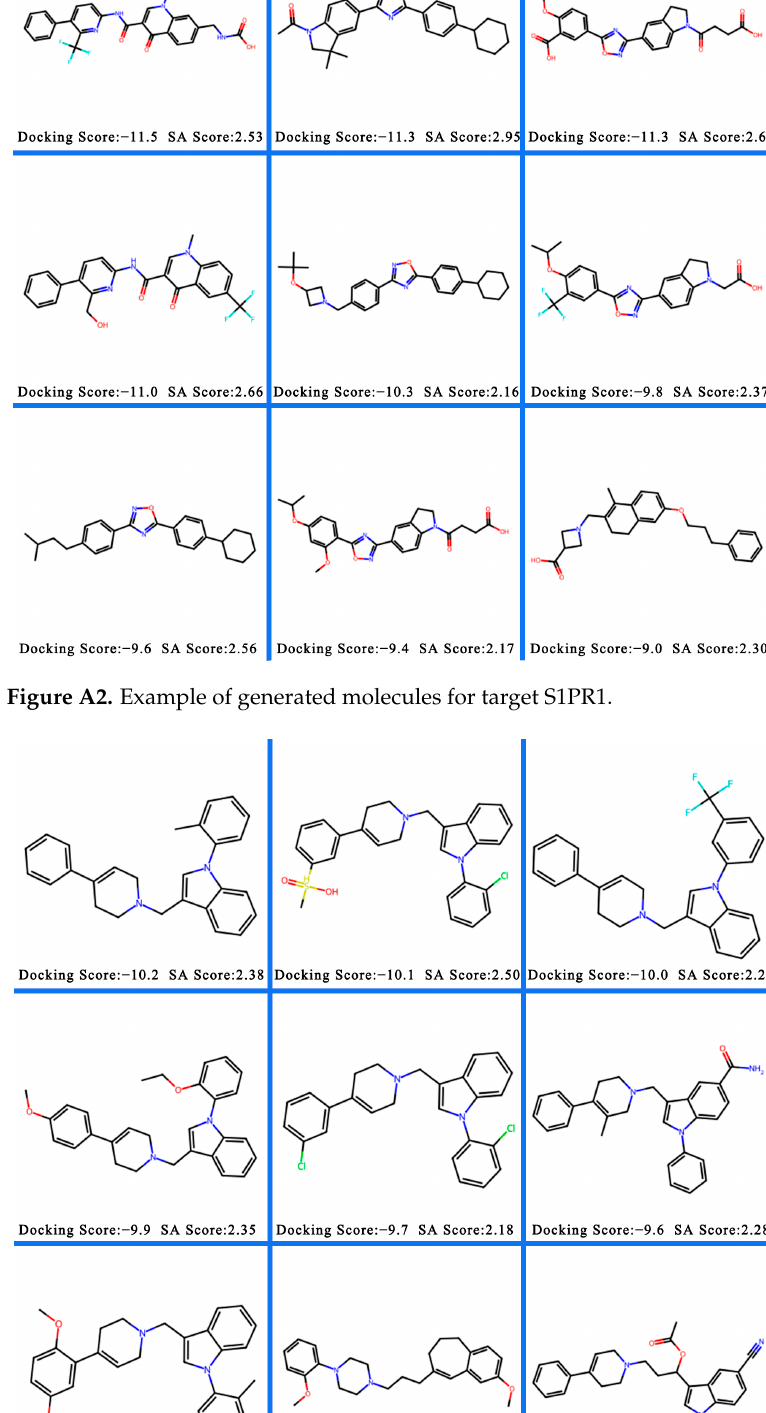
Figure A3. Example of generated molecules for target HTR1A.